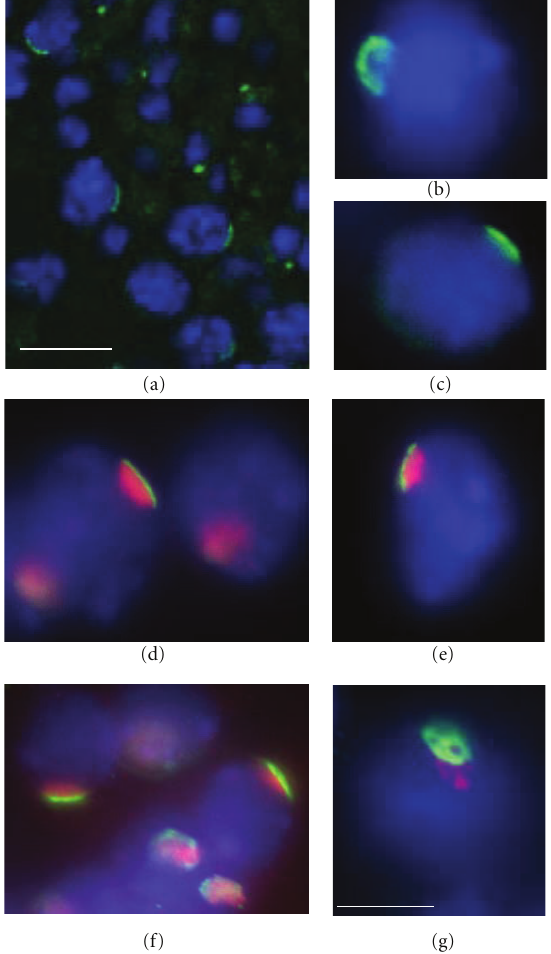
Figure 2: RFP defines a region underlying the XY body in pachytene spermatocyte. Immunofluorescent labeling of RFP on seminiferous tubule ((a), bar, 20 μ m) or in pachytene spermatocytes (b), (c). Coimmunolocalization of RFP and γ H2AX (d), (e) and RFP and SUMO-I (f), (g) in pachytene spermatocytes (bar, 8 μ m). In pachytene spermatocytes, RFP immunofluorescent staining (green) is condensed in a cap-like structure localized at the border of the nucleus (DAPI, blue). The XY body is visualized either by γ H2AX or SUMO-I antibodies (red). Superposition of labeling is never observed. The lace structure of RFP is evidenced when seen full face